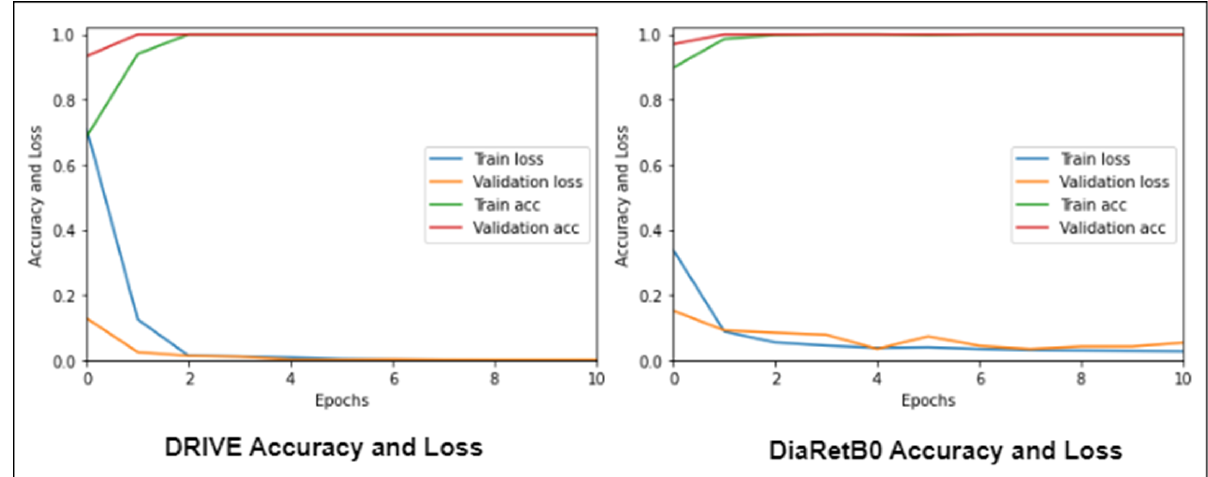
Figure 13. Mobile-HR accuracy and loss using the DRIVE and DiaRetB0 datasets.